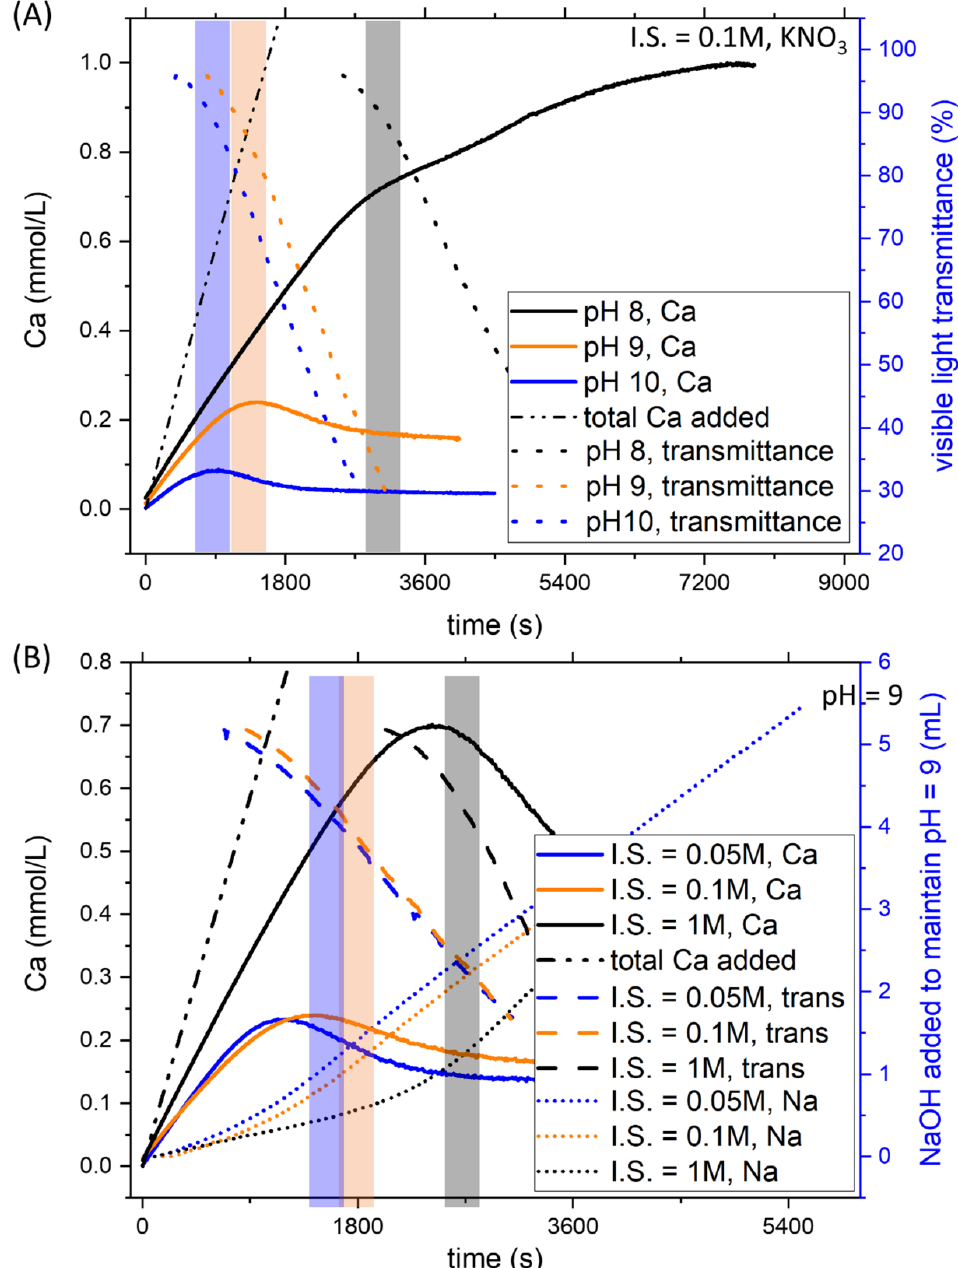
Figure 2. Examples of the titration results obtained for the system without Pb 2+ . ( A ) At constant ionic strength, a decrease of pH reduces the nucleation time, as demonstrated by the CaISE and Optrode signals. ( B ) An increase in the ionic strength while keeping pH constant delays nucleation. As ion-selective electrodes are very sensitive to ionic strength variations, the mL of dosed NaOH are also reported together with CaISE and Optrode signals.